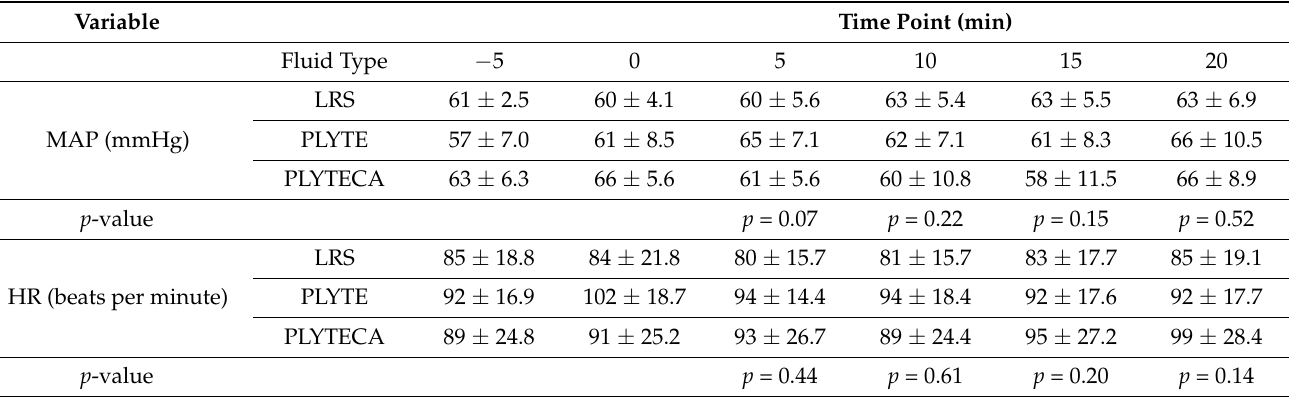
Table 3. Effect of LRS, PLYTE and PLYTECA on MAP and HR of hypotensive dogs under isoflurane